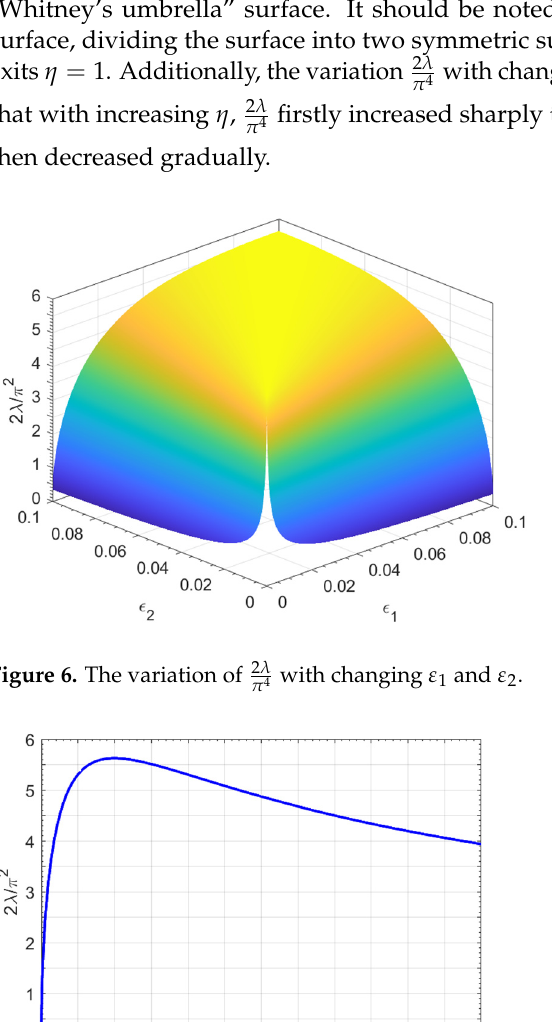
Figure 7. The variation of